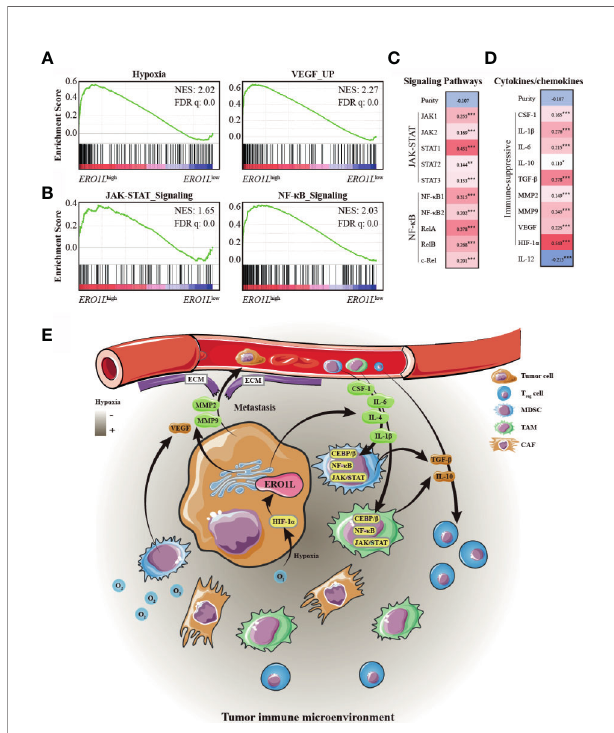
FIGURE 6 | Mechanisms underlying an ERO1L -associated immune- suppressive tumor microenvironment. (A) GSEA of ERO1L high expressing pro fi les using a hypoxia signature (NES =2.02, q =0.0) and a VEGF upregulated signature (NES =2.27, q =0.0). (B) GSEA of ERO1L high expressing pro fi les using an upregulated JAK-STAT signature (NES =1.65, q =0.0) and an upregulated NF- k B signature (NES =2.03, q =0.0). (C) Con fi rmation of gene expression changes in the JAK-STAT and NF- k B signaling pathways. (D) Correlations between ERO1L overexpression, cytokines, and chemokines patterns in the tumor immune microenvironment. (E) Schematic showing the ERO1L -induced immune-suppressive tumor immune microenvironment. * p < 0.05; ** p < 0.01; *** p <